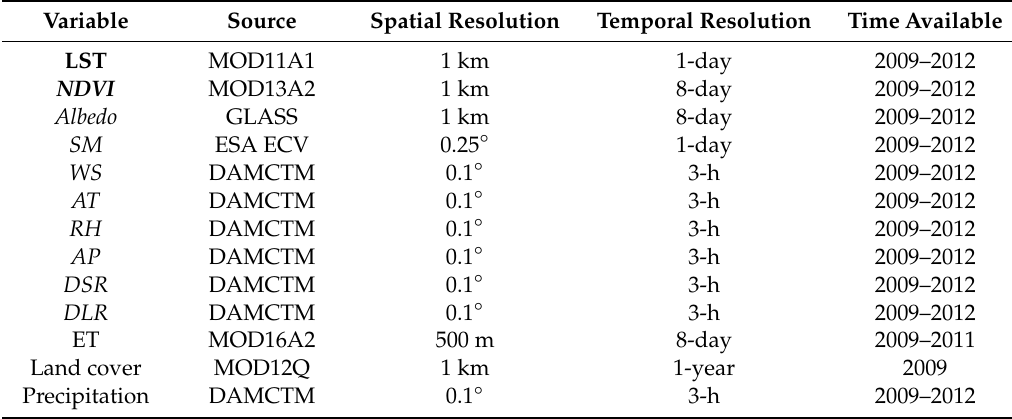
Table 1. Remotely sensed and meteorological forcing datasets used in this study. The variables in regular font are used in the Ts-VI triangle model, while the variables in italics are used in the deep neural network (DNN). Where LST: land surface temperature; NDVI: normalized di ff erence vegetation index; SM: soil moisture; WS: wind speed; AT: air temperature; RH: relative humidity; AP: air pressure; DSR: downward shortwave radiation; DLR: downward longwave radiation; ET: